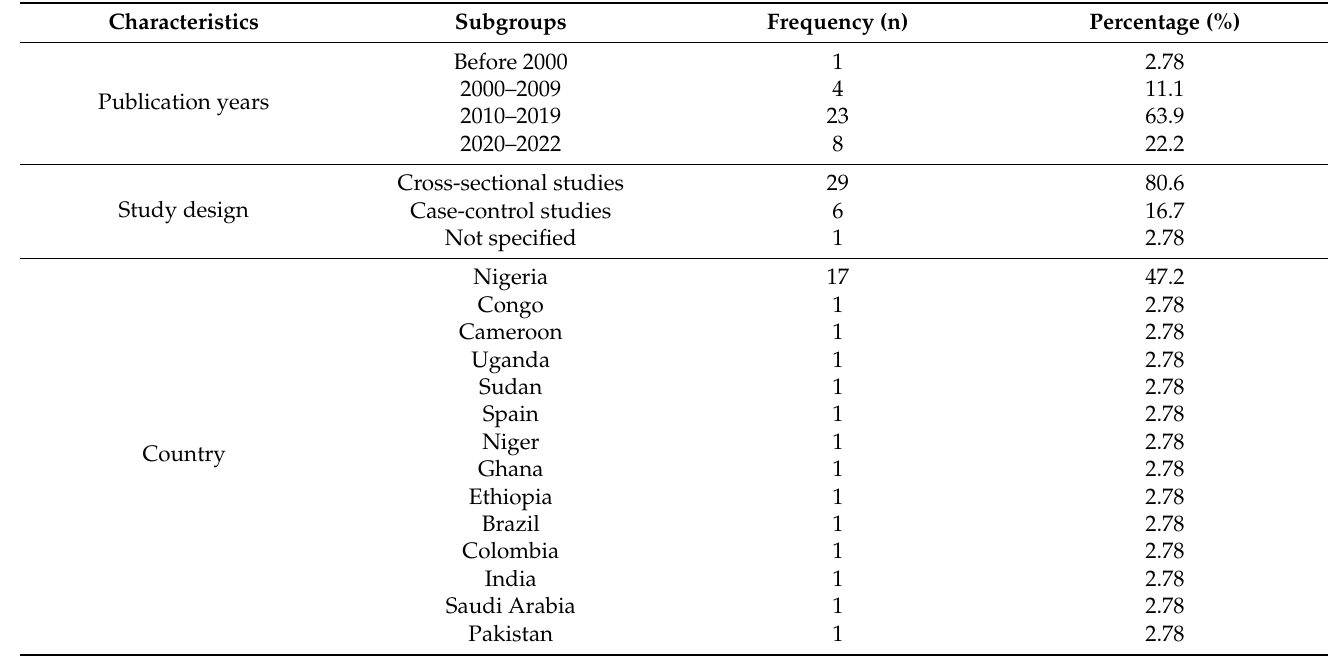
Table 1. Summary characteristics of 36 studies included in the review.